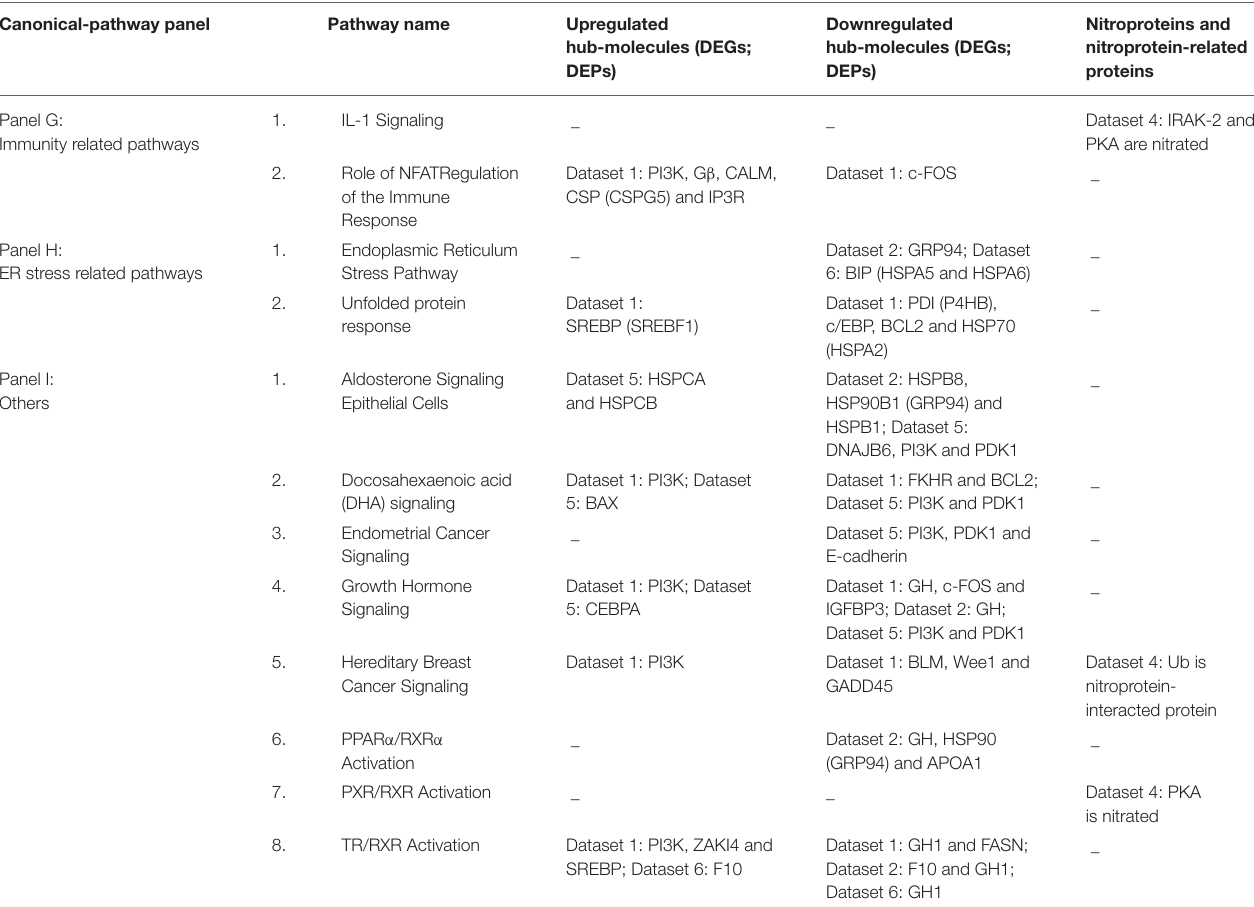
Canonical-pathway panel Pathway name